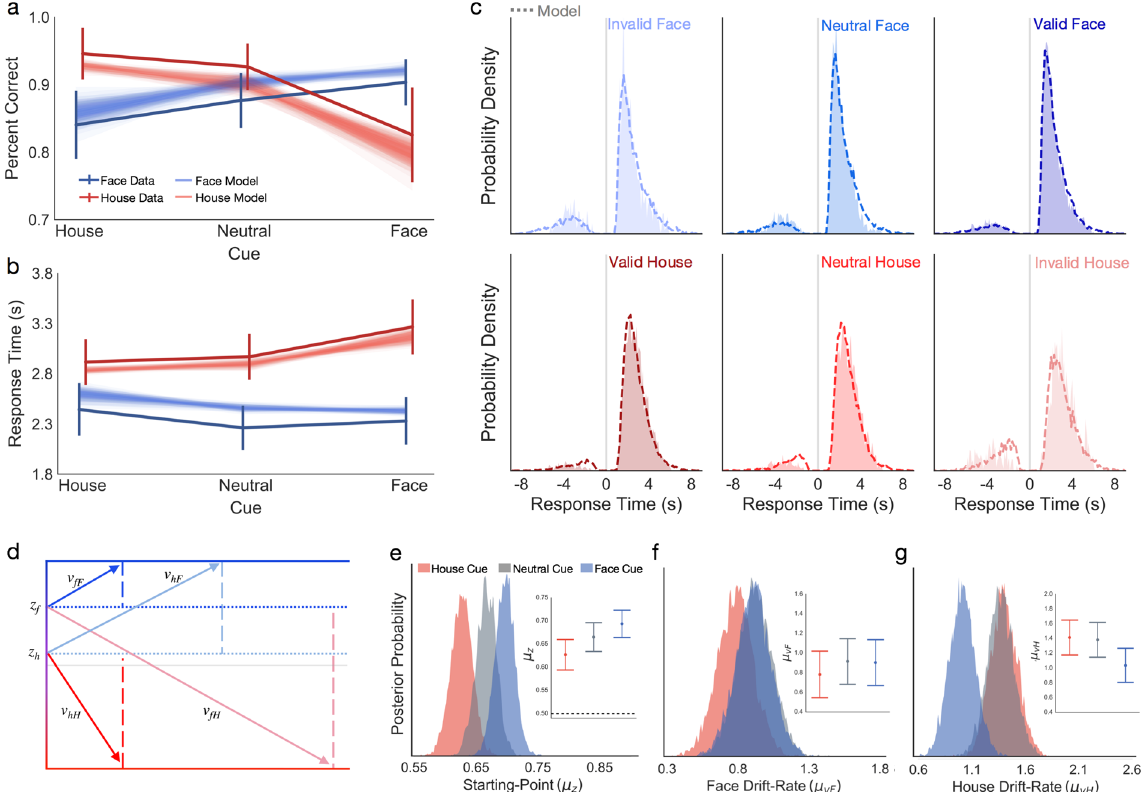
Figure 2. Observed and model-predicted effects of cued expectations on behavior. Average ( a ) accuracy and ( b ) RT (correct only) of face (dark blue line) and house (dark red line) decisions plotted as a function of cue type across subjects (N = 19). Model-predicted accuracy and RT data for each stimulus category are shown as overlays (face: transparent blue; house: transparent red), each line corresponding to predictions from one of 100 simulated datasets. Each simulated dataset was generated using the subject-level parameter estimates of the hierarchical MSM model and contained the same trial count per condition as in the actual experiment to capture predicted estimates of variability. ( c ) Observed (filled) and model-predicted (dashed line) RT distributions for face (blue, top) and house (red, bottom) stimuli, plotted separately for invalid (lighter), neutral, and valid (darker) cued expectations. Error RTs are flipped on the x-axis (left of vertical gray line). Correct RTs are plotted as positive values (right of vertical gray line). ( d ) Schematic showing the effects of valid and invalid prior cues on starting point and drift rate parameters. Posterior probability distributions for ( e ) starting point ( z cue ), ( f ) face drift-rate ( v F ), and ( g ) house drift-rate ( v H ) estimates in the 80F (Face, blue), 50N (Neutral, gray), and 80H (House, red) cue conditions. Error bars in panels ( a , b ) show the 95% c.i. around the mean. Inset plots in panels (e–g) show the mean and 95% c.i. of the posterior probability distribution for each of the